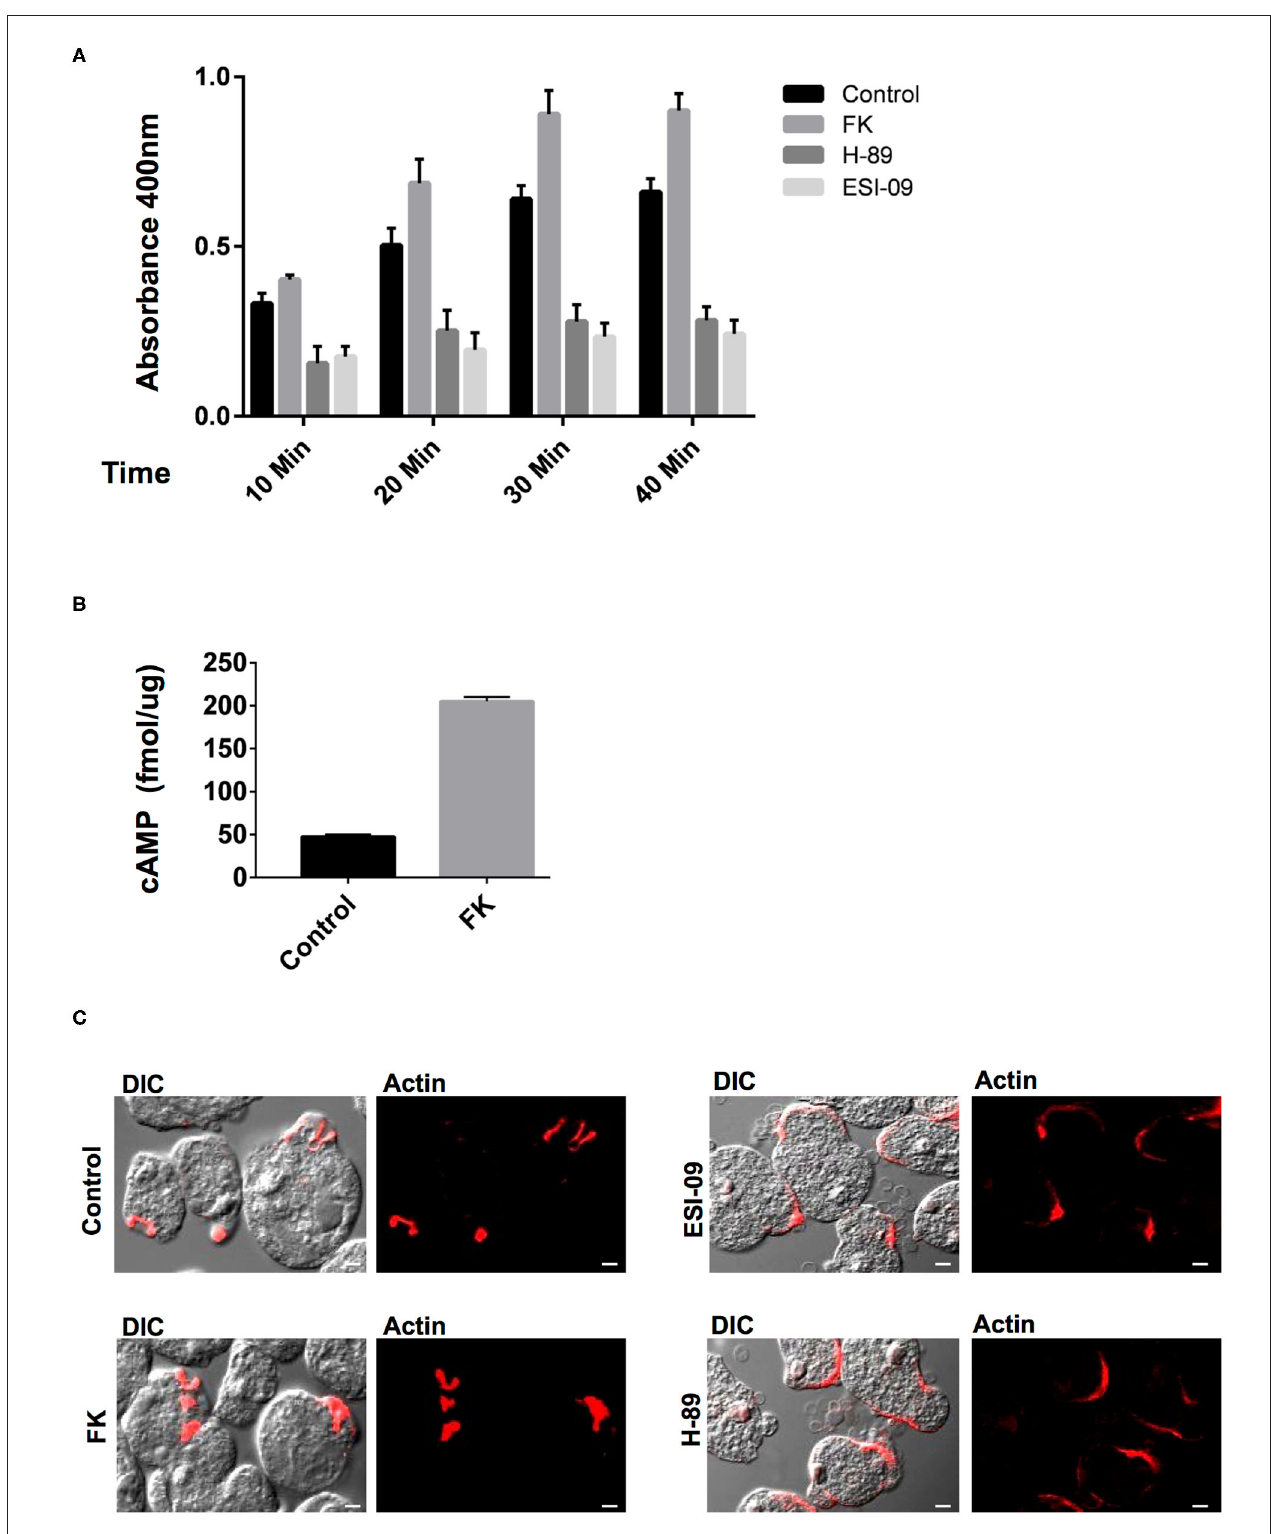
FIGURE 3 | Pharmacological manipulation of the elements of cAMP signaling pathway and their role in phagocytosis. (A) The graph represents the spectrophotometer reading for RBC uptake by E. histolytica cells pre-treated with either Forskolin (FK), H-89 and ESI-09, or DMSO control at 10, 20, 30, and 40min.